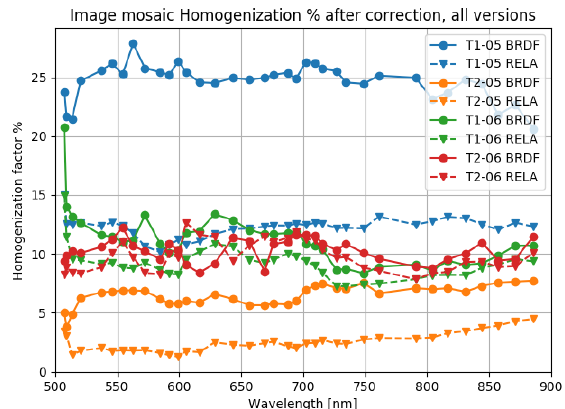
Figure 3. Image mosaic DN homogenization improvement per band of each data set after radiometric correction. FPI band centre wavelengths are marked with circles and triangles.